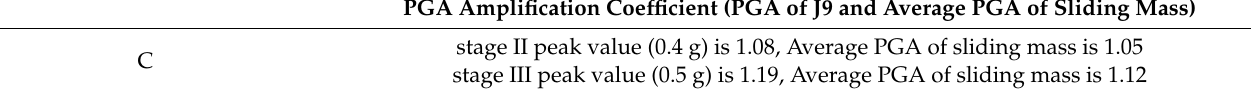
Table 7. Cont. PGA Amplification Coefficient (PGA of J9 and Average PGA of Sliding Mass)